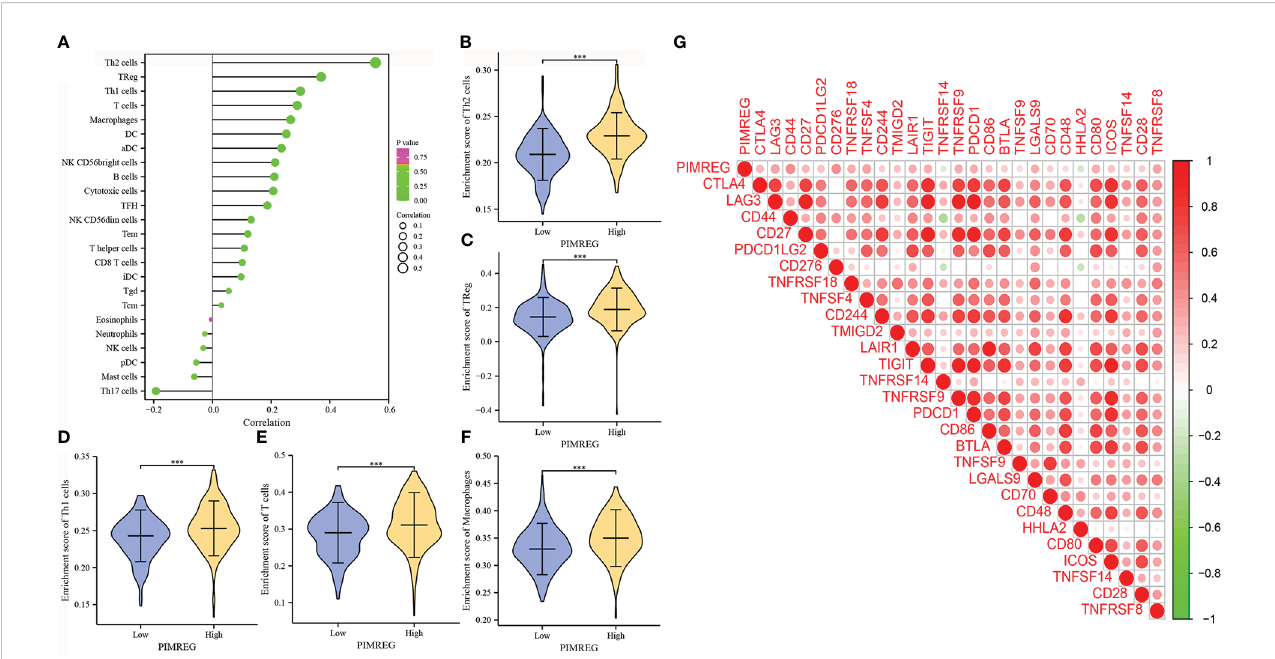
FIGURE 7 PIMREG is associated with immune cell in fi ltration and immune related genes. (A) Correlations of PIMREG expression levels with immune in fi ltration level. (B-F) PIMREG expression is positively related to enrichment scores of Th2 cells, TReg, Th1 cells, T cells and macrophages in ccRCC. (G) Corrplot graph shows the correlation between PIMREG and different immune related genes. ccRCC: clear cell renal cell carcinoma; ***P < 0.001.